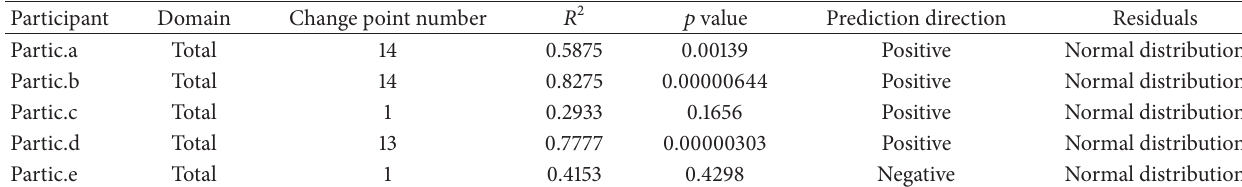
Table 2: Analysis of the HEATTOTAL of individual participants.